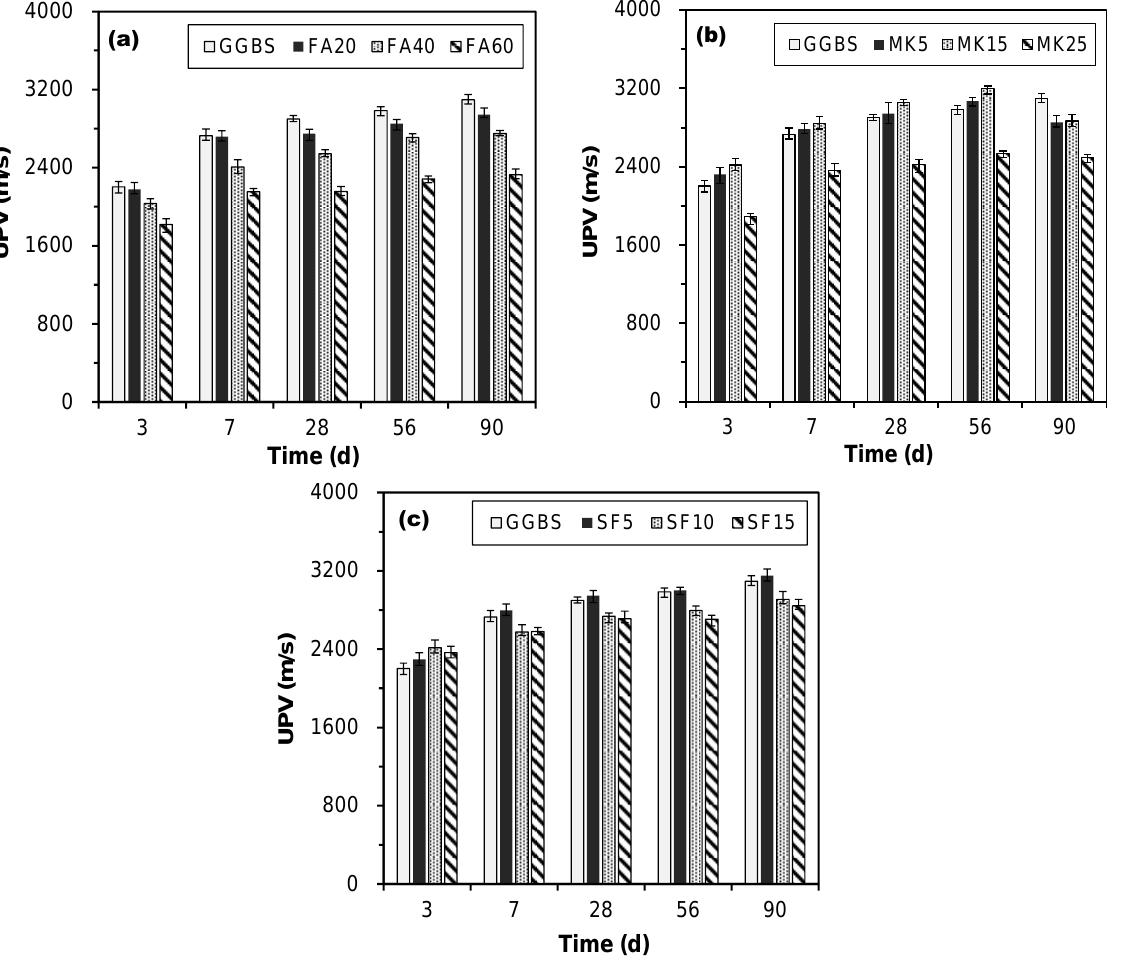
Figure 14. ( a ) UPV results of AAS-CPB containing ( a ) FA; ( b ) MK; and ( c ) SF.